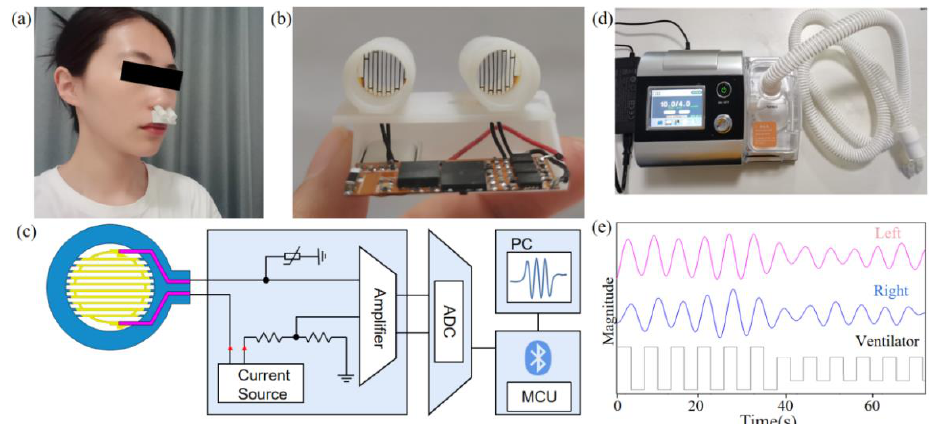
Figure 6. ( a ) Photograph of the device worn below the nose. Subject: 23 years of age, female, non-professional healthy volunteer. ( b ) Device with wires is connected to external circuit modules. ( c ) Architecture of signal acquisition circuit. ( d ) Experimental setup for respiration simulation. ( e ) Monitoring results of simulated respiratory signals.